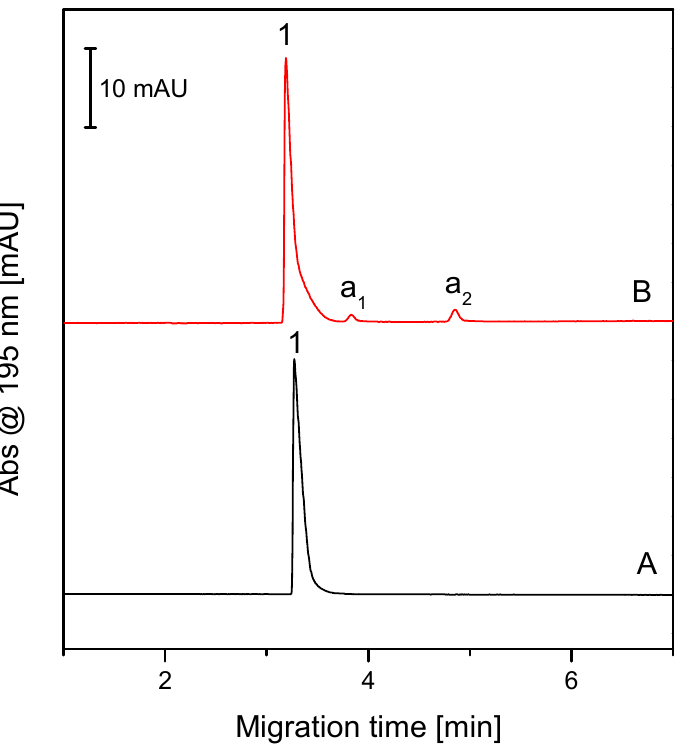
Figure 6. Comparison of CZE analysis of the dipeptide β -Ala-Tyr after ( A ) and before ( B ) its purification by FFZE. For the experimental conditions, see Figure 4 and Section 2.3.1.